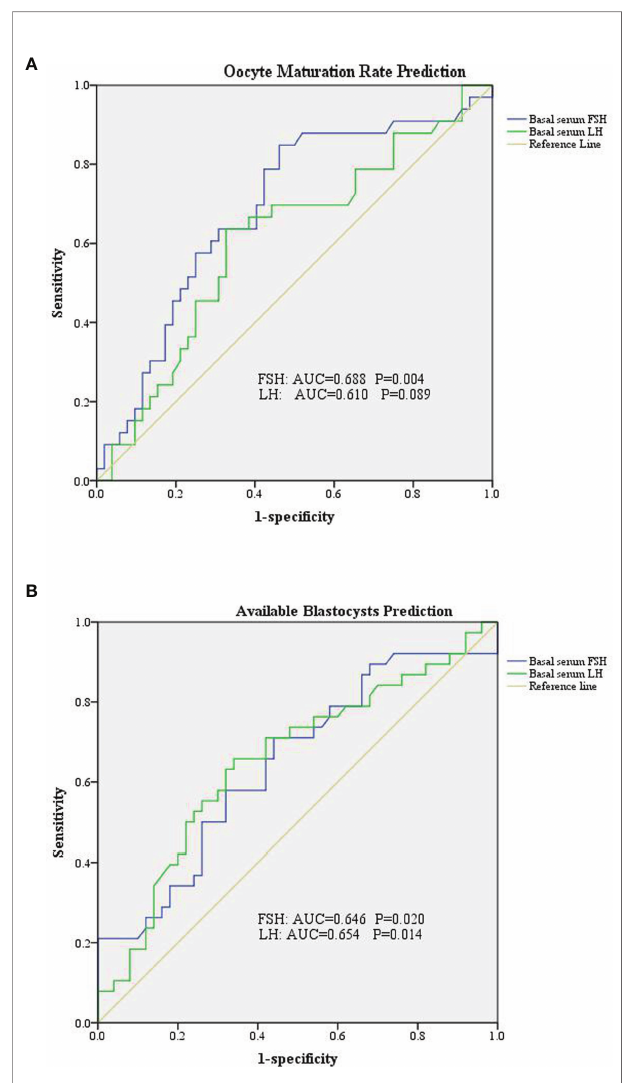
FIGURE 3 | Receiver operating characteristic curve of basal serum FSH and LH in prediction of oocytes and embryological outcomes. (A) Basal serum FSH has predictive value for oocyte maturation rate. (B) Both basal serum FSH and basal serum LH has predictive value for available